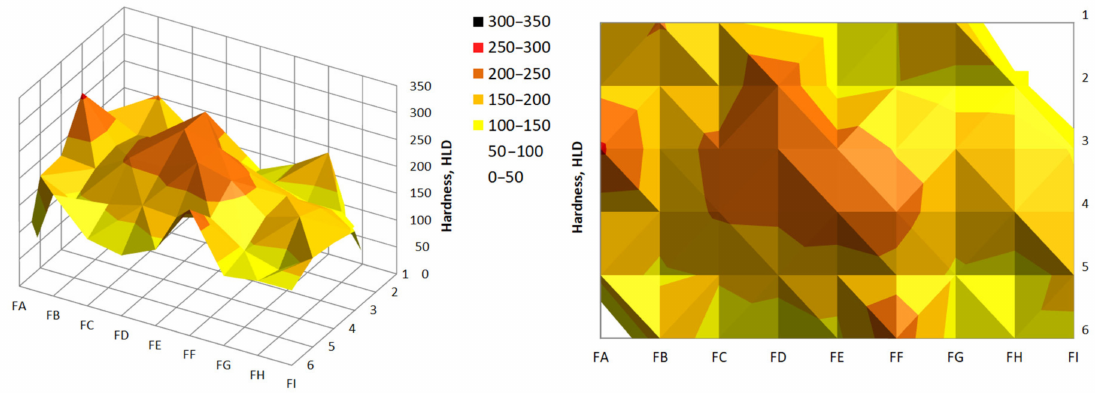
Figure 15. Hardness distribution on the front surface of the briquette.